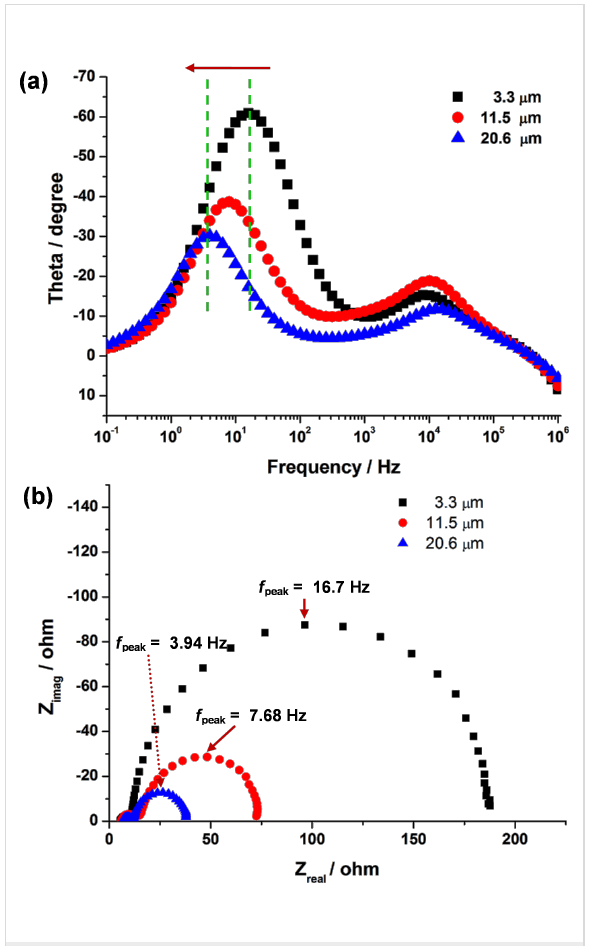
Figure 4: Experimental impedances of the N719-DSSCs fabricated using 3.3 μ m, 11.5 μ m, and 20.6 μ m TNT arrays. (a) Bode phase plots and (b) Nyquist